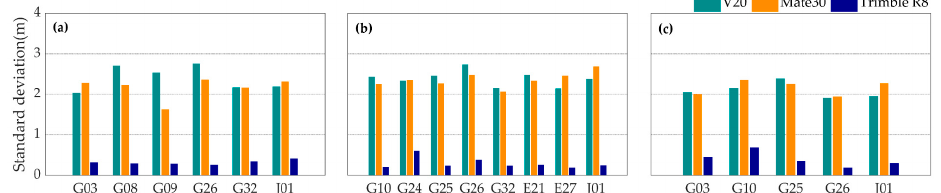
Figure 8. The standard deviations values of L1 frequency code multipath error of the V20 (cyan), the Mate30 (orange) and the Trimble R8 (blue) during the first ( a ), the second ( b ) and the third ( c ) observing periods.